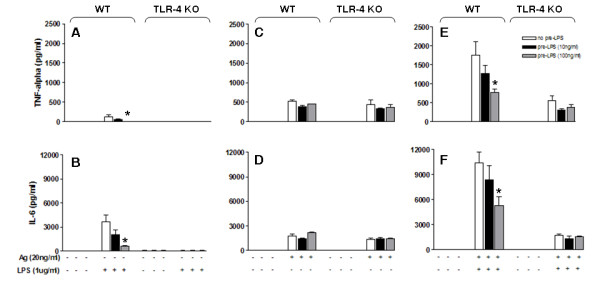
Effect of LPS prestimulation on cytokine production after a second challenge with LPS, antigen, or a combination of both. Reduction of TNFα (A) and IL-6 (B) production after stimulation with 1 μg/ml LPS in BMMC prestimulated with 10 ng/ml LPS (p = 0.18) and 100 ng/ml LPS (p = 0.01). No significant reduction of TNFα (C) or IL-6 (D) production was observed after stimulation with 20 ng/ml Ag in cells prestimulated with 10 ng/ml LPS (p = 0.057) and 100 ng/ml LPS (p = 0.17). Attenuation of potentiation of TNFα (E) and IL-6 (F) production by simultaneous stimulation with 20 ng/ml Ag and 1 μg/ml LPS when BMMC were prestimulated with 10 ng/ml LPS (p = 0.16) and 100 ng/ml LPS (p = 0.01). The TLR4 KO BMMC graphs (A-F) demonstrate that potentiation and attenuation with the FCεR1 agonist and LPS is mediated by TLR4 because there is no significant difference between the non-prestimulated and prestimulated groups. Of note, the synergy with the combination of LPS+Ag for TNFα (E) and for IL-6 (F) is no longer observed in TLR4 KO BMMC. Values are mean and SEM from 3 independent experiments.